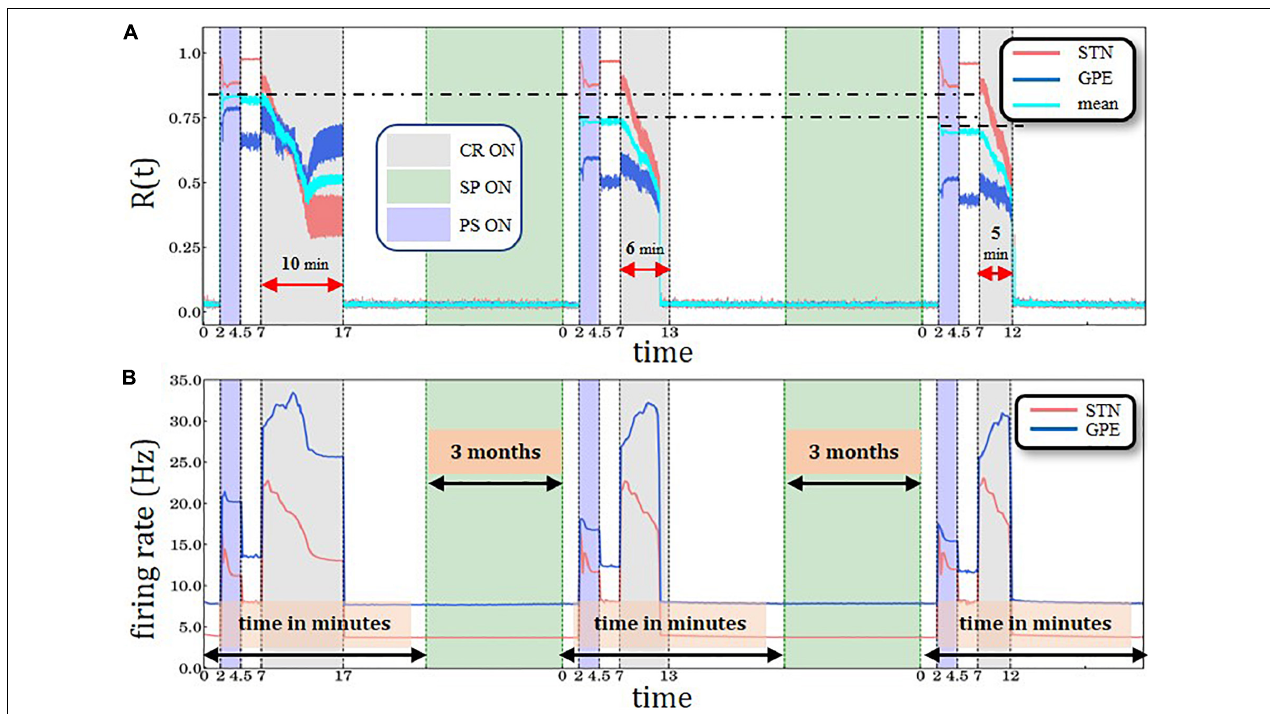
FIGURE 5 | Periodic Stimulation-Coordinated Reset sequence with long CR epoch followed by two PS-CR sequences with reduced CR duration, with structural plasticity (SP) with 3.0 Hz target firing rate. (A) A sliding window of 100 simulation time steps at each different epoch when STDP or structural plasticity was active for STN (red solid line) and GPe (blue solid line) neurons and the average value for the whole network (cyan solid line). (B) Spiking rates for STN and GPe neurons, respectively. PS, CR, STDP, and structural plasticity activation interval period color coding and units are defined in Figure 3